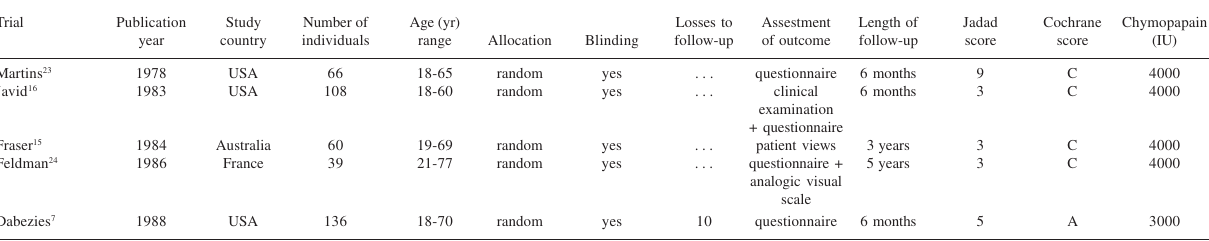
Table 1 - Clinical trials of chemonucleolysis versus placebo Trial